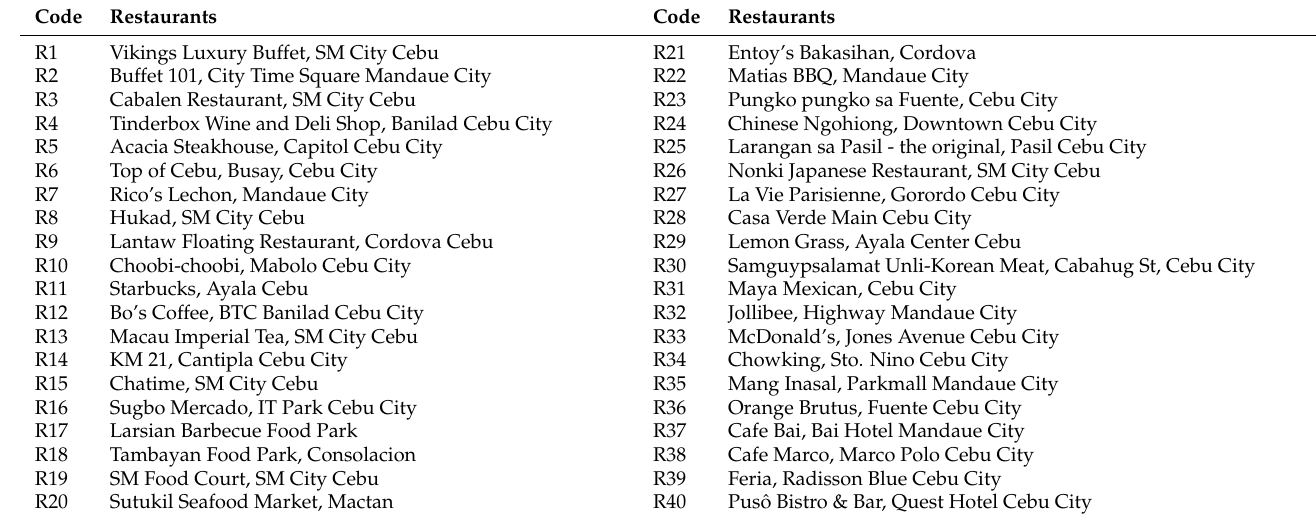
Table 9. List of restaurants under evaluation